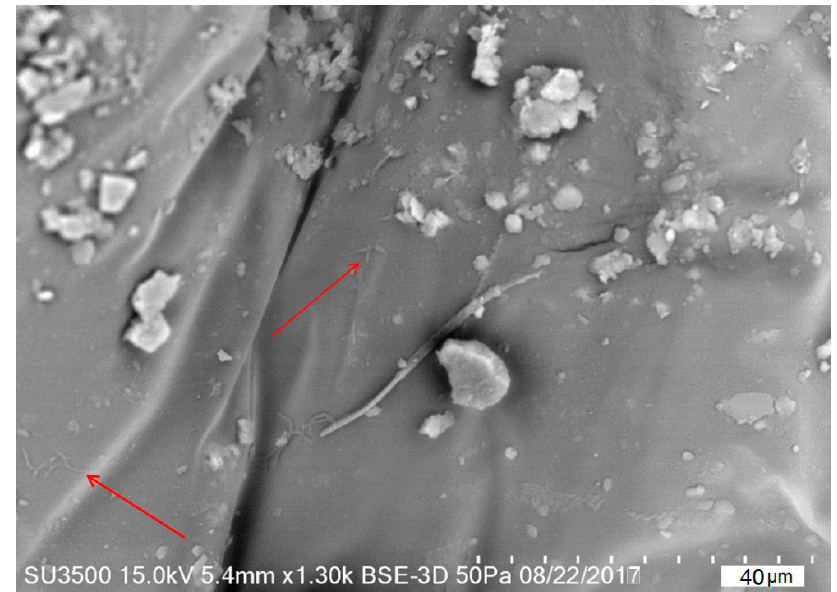
Figure 10. SEM image of the lignin surface colonised in the WAF + SS + Lignin sample.